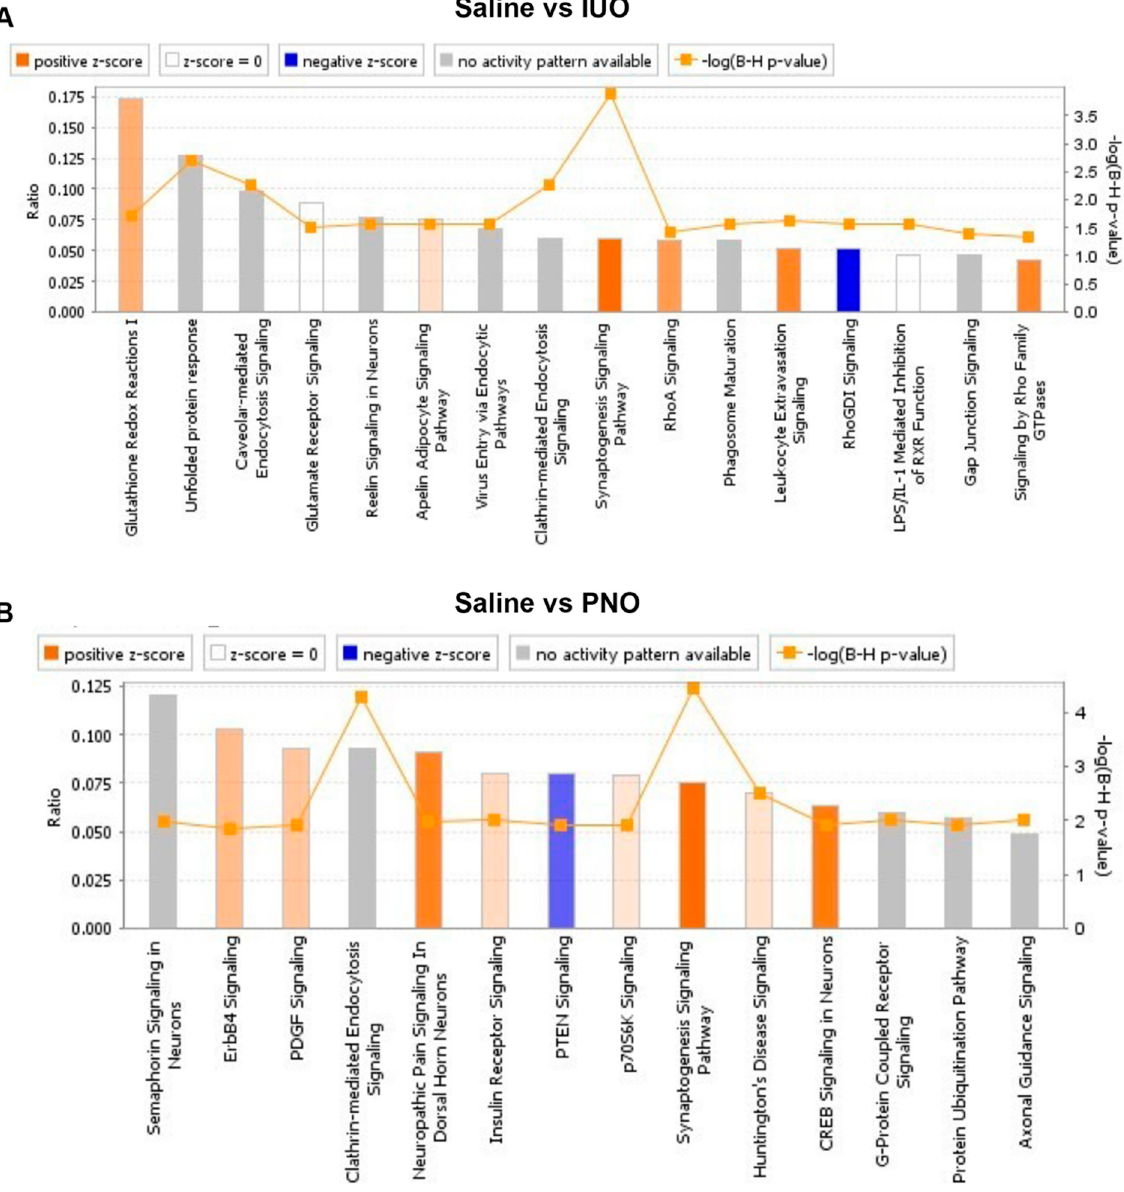
Figure 5. Ingenuity pathway analysis (IPA). IPA reveals several enriched canonical disease-associated pathways within both PNO ( A ) and IUO ( B ) comparisons. The pathways are ranked by the negative log of the FDR corrected p -value of the enrichment score and color coded according to the Z-score. A significantly increased pathway activity is indicated by a positive Z-score represented by the orange bars and an overall decrease in pathway activity is represented by a negative Z-score represented by blue bars. Gray bar represents enriched pathways with no predicted activity change.